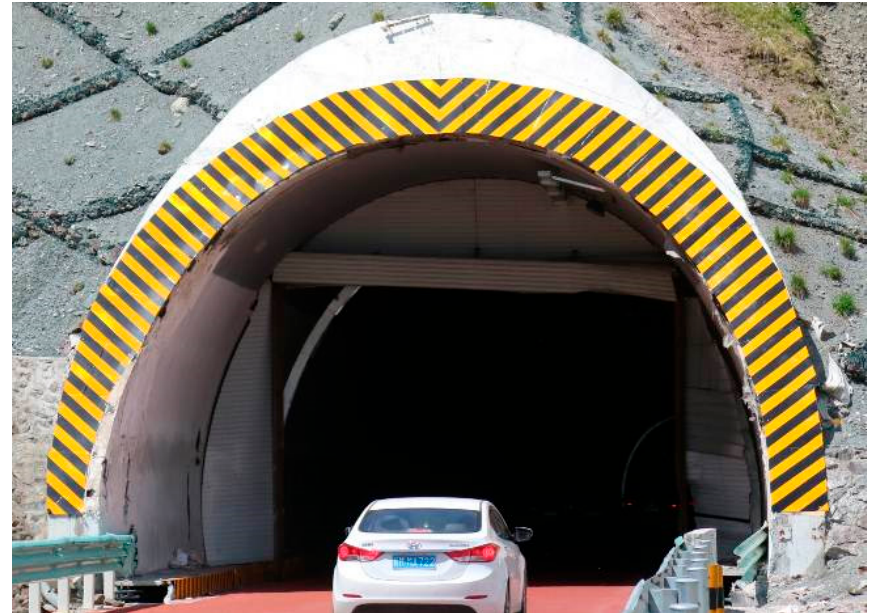
Figure 5. Thermal insulation gate at the entrance of Yuximolegai tunnel (photographed by Y.F Zhou).